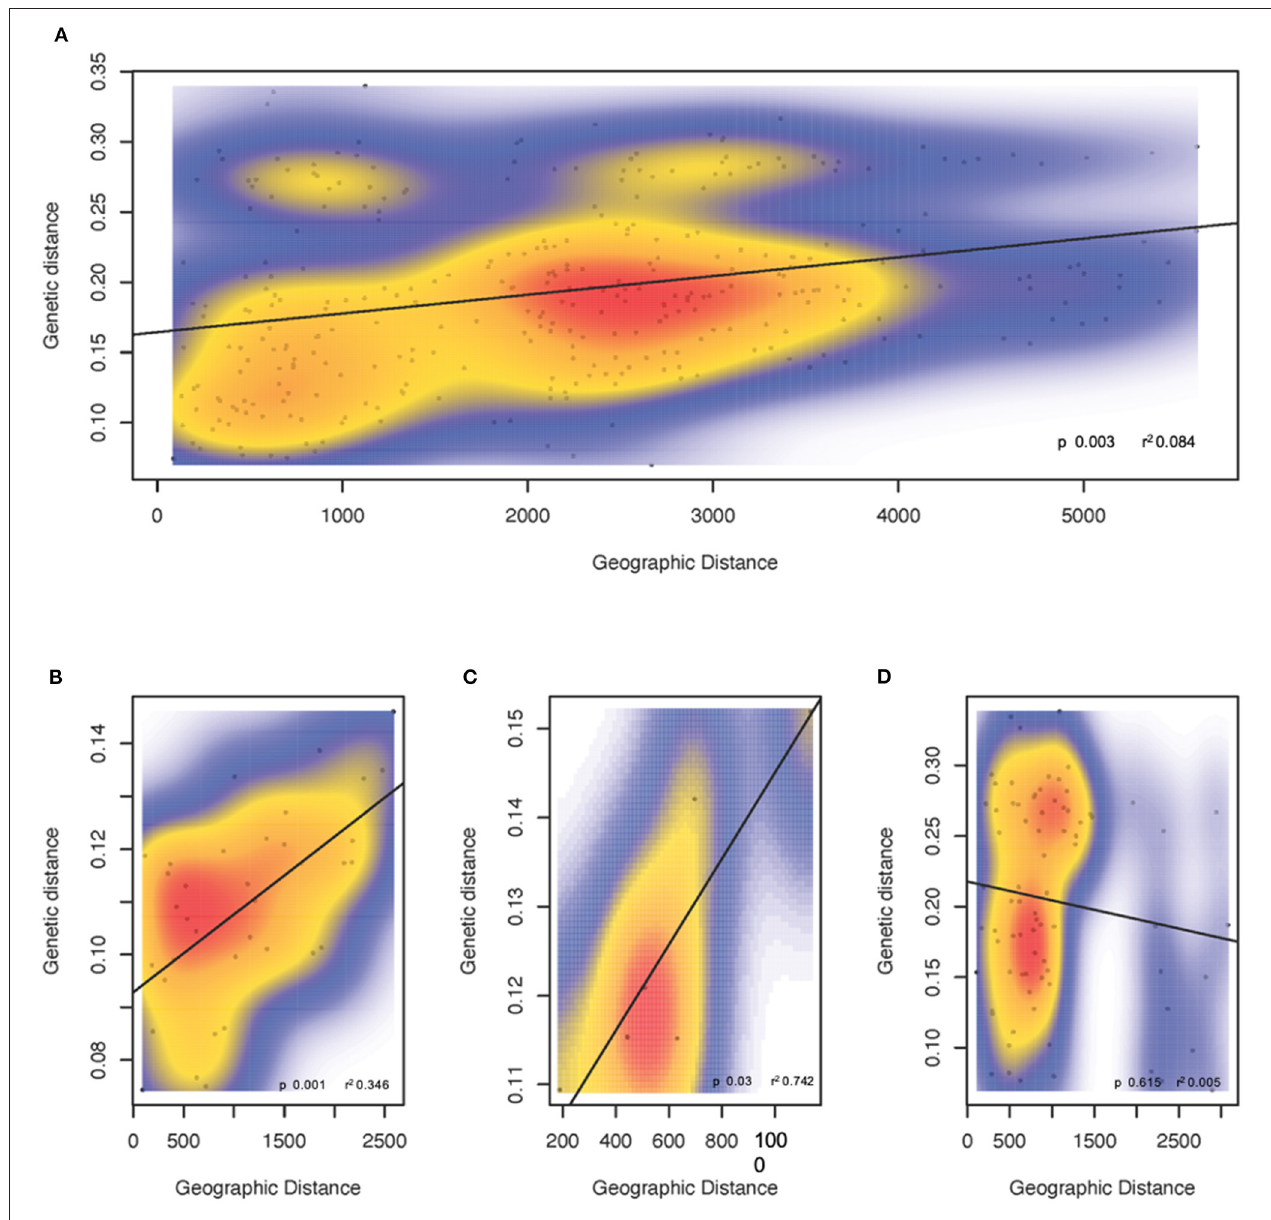
FIGURE 4 | Isolation by distance between F ST values and the shortest waterway distance based on 14,799 SNPs for Australasian common dolphins ( Delphinus delphis ). (A) Australia and New Zealand metapopulation; and regional populations, (B) Southern coast of Australia, (C) Eastern coast of Australia, and (D) New Zealand and